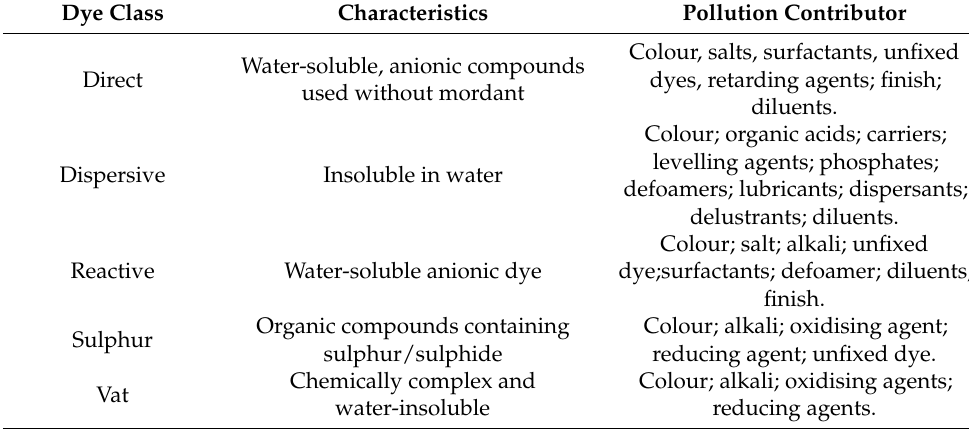
Colour, salts, surfactants, unfixed dyes, retarding agents; finish; diluents. Colour; organic acids; carriers; levelling agents; phosphates; defoamers; lubricants; dispersants; delustrants; diluents. Colour; salt; alkali; unfixed dye;surfactants; defoamer; diluents; finish. Colour; alkali; oxidising agent; reducing agent; unfixed dye. Colour; alkali; oxidising agents; reducing